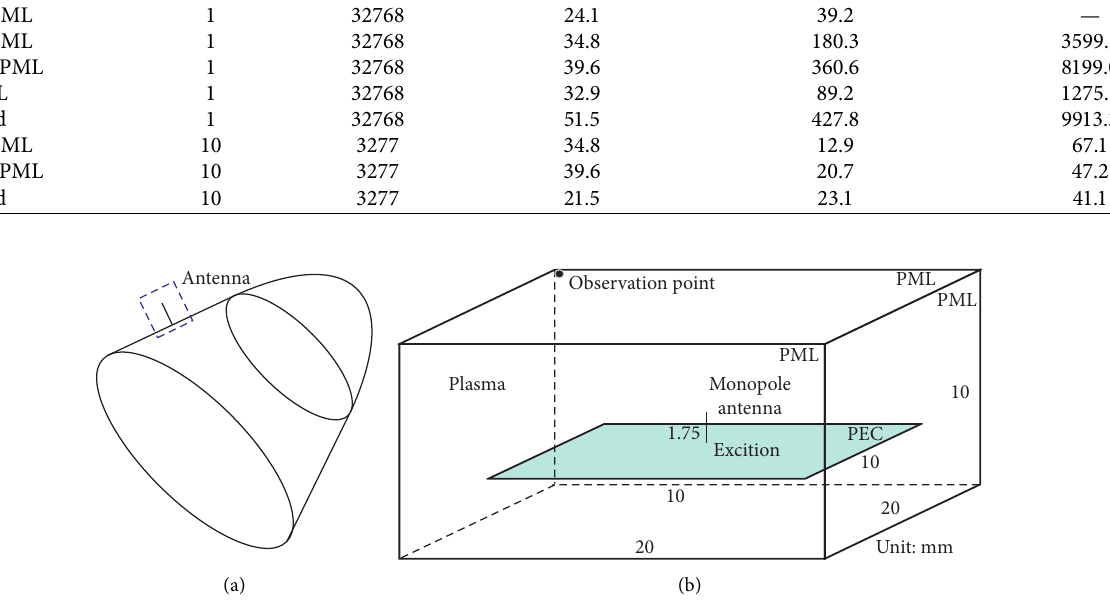
Figure 5: Comparison of the RCS versus frequency between flight vehicle with plasma sheath and flight vehicle without plasma sheath obtained by CNDS-HO-PML with CFLN � 10. Table 1: The memory consumption, CFLN, CPU time, iteration steps, and time reduction obtained by different PML algorithms. PML algorithms CFLN